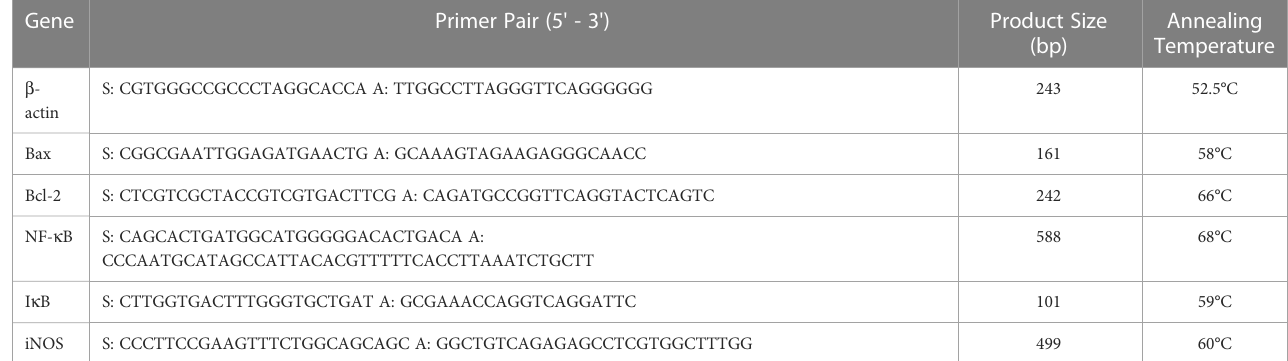
TABLE 1 Details of primer genes, product size and their respective annealing temperatures used in semiquantitative polymerase chain reaction.